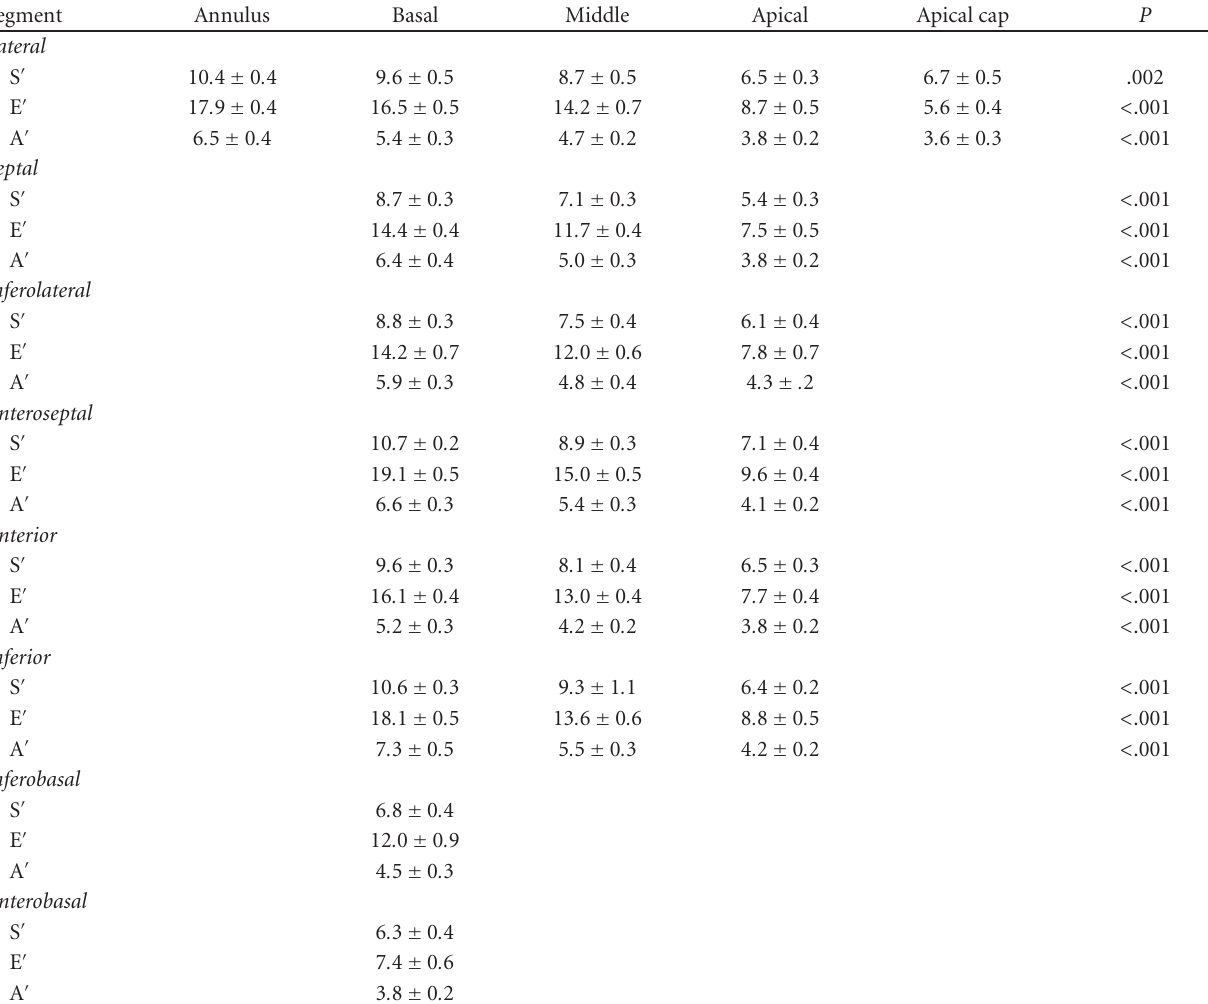
Table 2: Resting tissue Doppler velocities of